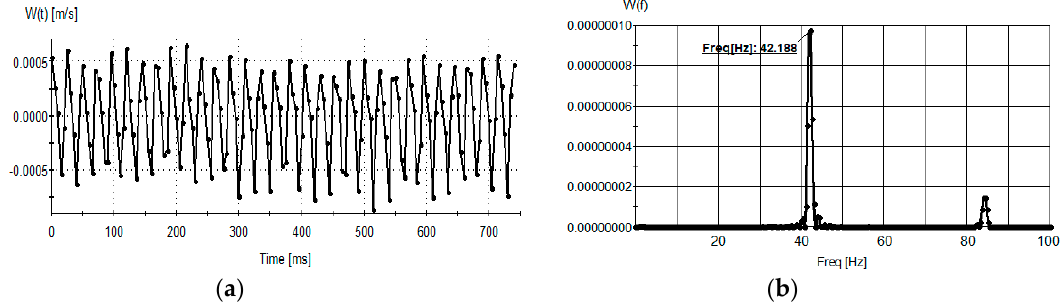
Figure 18. ( a ) Time series of the out of plane velocity component at the red circle in Figure 17d. ( b ) The spectrum of the out-of-plane velocity component in Figure 18a.